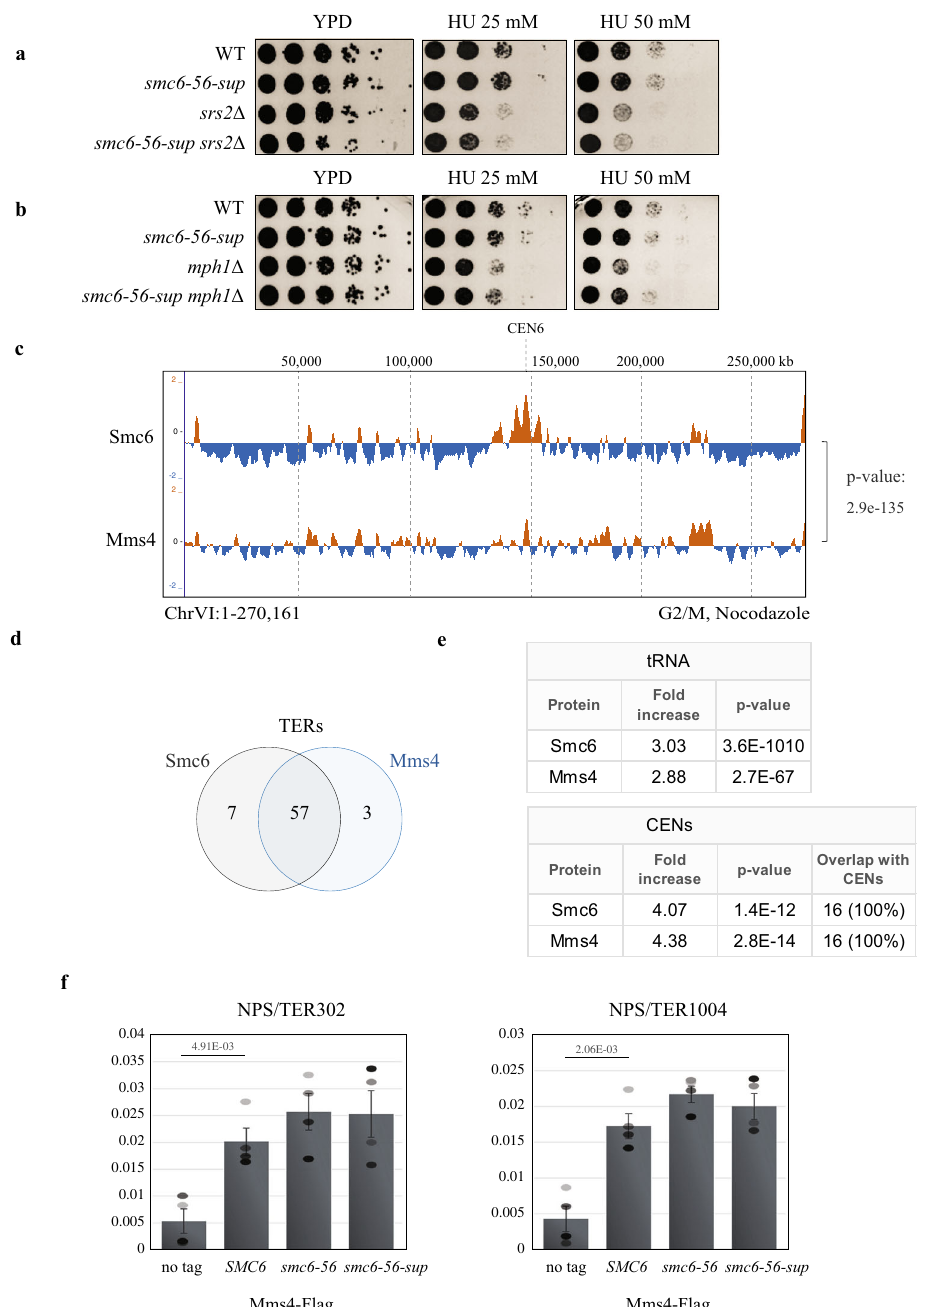
Fig. 7 Genetic relationship between Smc6-56-sup and DNA processing factors, and Mms4 – Mus81 enrichment at NPSs. a , b No additivity between smc6-56-sup and srs2 Δ , mph1 Δ in regard to HU sensitivity. The experiments were repeated independently twice with similar results. c ChIP-on-chip pro fi le of HA-Mms4 and Smc6-Flag from G2/M-synchronized cells. Chr VI is shown as example. The indicated p -values (one-tailed Fisher ’ s exact test) relate to the genome-wide overlap between the considered protein clusters. d Mms4 is enriched at NPSs that serve as termination sites (TERs) in G2/M. Values of overlap and non-overlap between Mms4 and Smc6 are shown. e fold increase of Mms4 at tRNA genes and centromeres (CENs) calculated versus the ones expected for random binding, and the p -values (one-tailed Fisher ’ s exact test) of the signi fi cance (see legend of Fig. 1a for details). f ChIP-qPCR analysis of Mms4-Flag in WT, smc6-56 and smc6-56-sup versus no tag in G2/M phase at two indicated NPSs. The plotted values are derived from three biological replicates, the data are presented as mean value ± SEM. p -values were calculated by an unpaired two-tail t -test. See also Supplementary Fig. 7. Source data are provided as a Source Data fi regions to accumulate DNA supercoiling and intertwines, which can be recognized by Smc5/6 to facilitate local compaction 11,12,63 . Smc5/6 prevents genome fragility in mammalian cells and bud- ding yeast 5,8,18,23,24 , but the mechanisms involved remain to be clari fi ed.